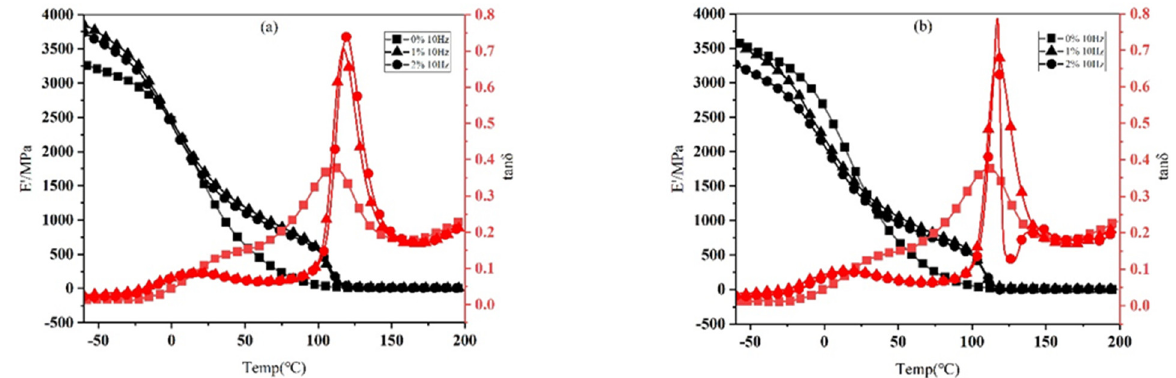
Figure 6. Dynamic thermomechanical properties of the material in tensile mode at a test frequency of 10 Hz with different CGF contents. ( a ) T direction, ( b ) W direction.